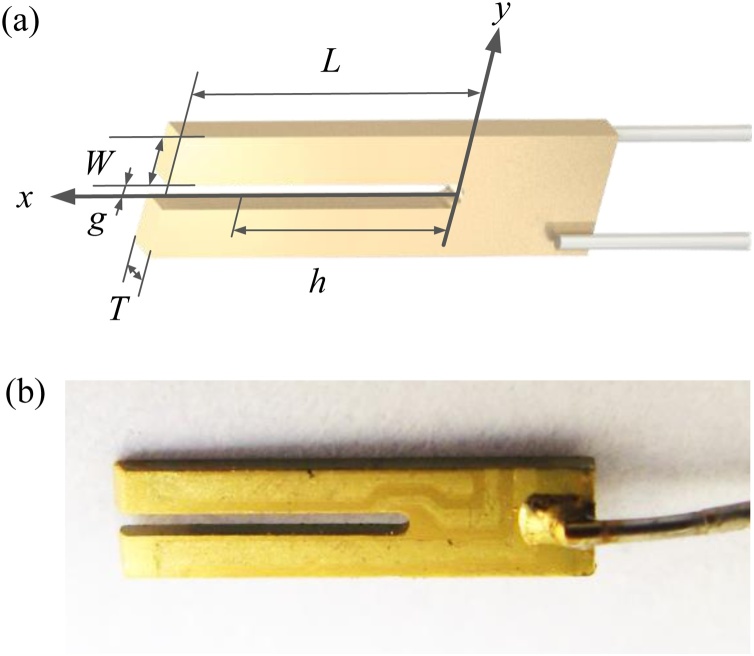
a) Diagram of the QTF dimension; (b) Photograph of the QTF taken with an optical microscope.